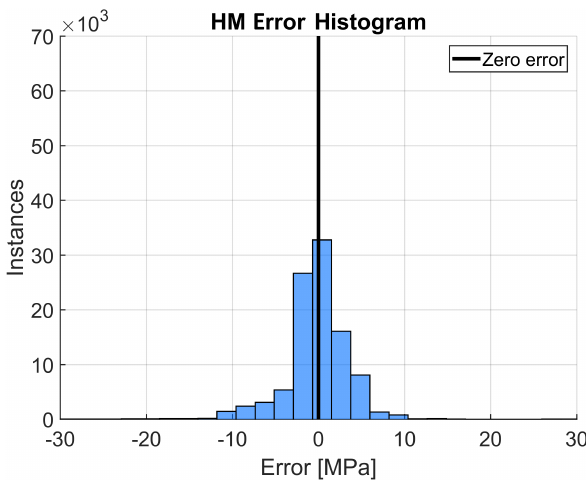
Figure 11. Error histogram for the HM with 30 bins and a bin width of around 2.2 MPa. The results displayed are the difference between the experimental and predicted stress values.